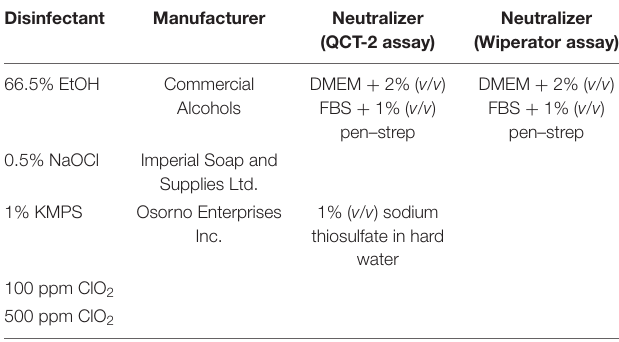
TABLE 1 | Disinfectants and associated neutralizers used in the present